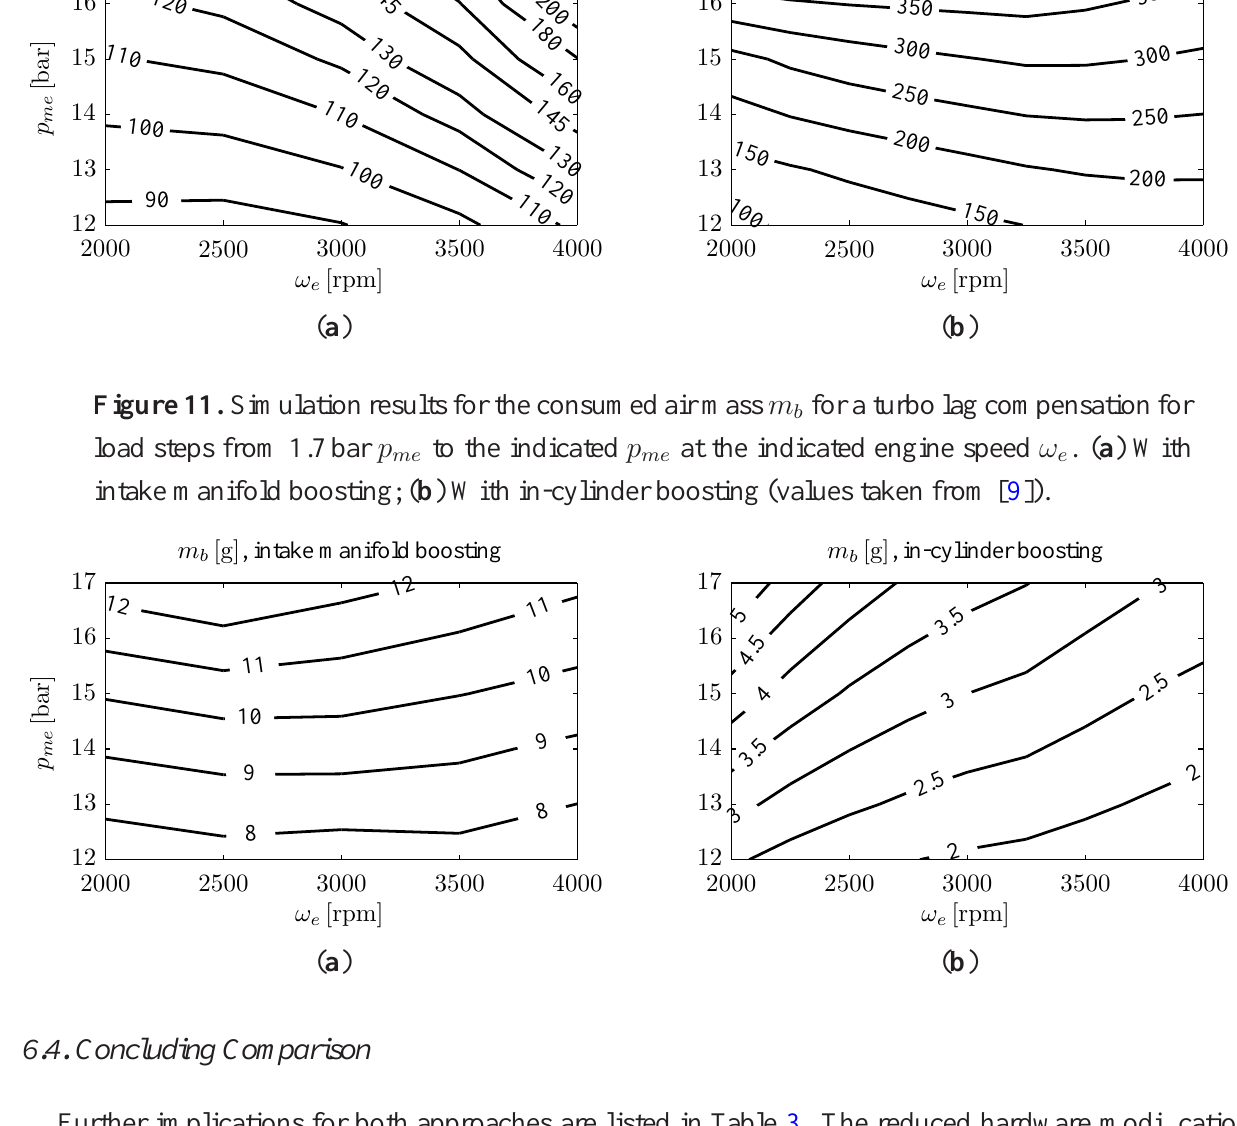
Figure 10. Simulation results for the rise times for a turbo lag compensation for load steps from 1.7 bar p to the indicated p at the indicated engine speed ω me me manifold boosting; ( b ) With in-cylinder boosting (values taken from [9]).